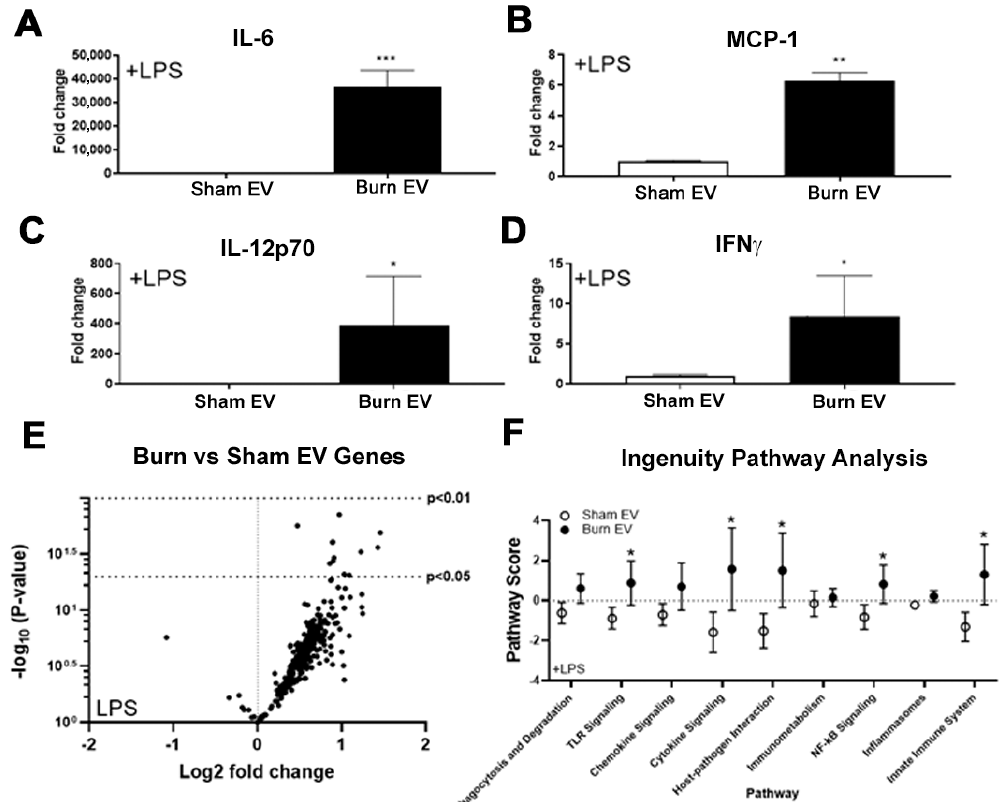
Figure 2. Plasma extracellular vesicles (EVs) after burn injury promote pro-inflammatory signaling in macrophages. Adult mice underwent a 20% total body surface area (TBSA) burn injury and plasma EVs were collected 48 h after injury. EVs from burn injury mice (Burn EV) or sham injured mice (Sham EV) were applied (3 × 10 7 /well) to splenic macrophages +/ − LPS (100 ng/mL) for 24 h. ( A – D ) Media cytokines were measured by multiplex. Burn EVs cause robust increases in pro-inflammatory ( A ) IL-6, ( B ) MCP-1, ( C ) IL-12p70, and ( D ) IFN¦ Ã in macrophage media. * p < 0.05, ** p < 0.01, *** p < 0.001 vs. sham EVs, t -test. ( E , F ) Macrophage lysates were harvested, mRNA isolated, and gene changes measured by NanoString. ( E ) Volcano plot of several genes significantly induced by burn-EVs relative to sham EVs. ( F ) nSolver pathway analysis scores of changes in measured immune pathways. Burn EVs significantly altered TLR signaling, cytokine signaling, host-pathogen interactions, NFkB signaling, and the innate immune system in macrophages relative to sham